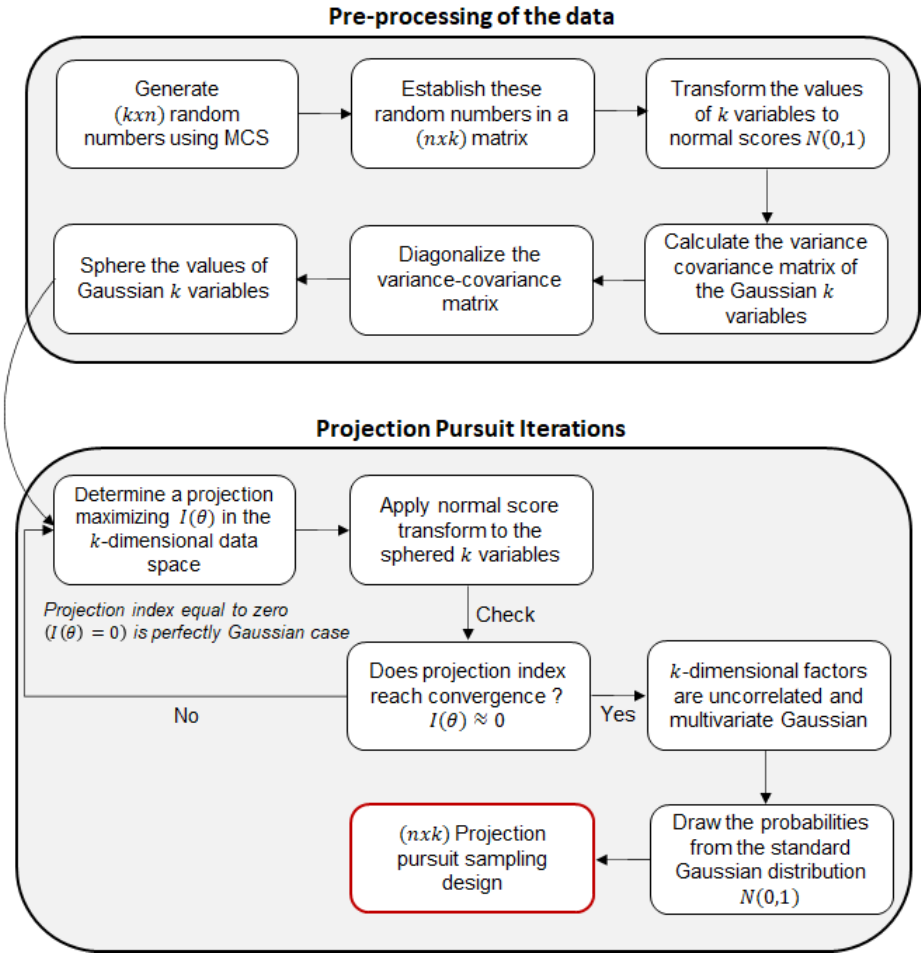
Figure 4. A flowchart indicating the steps for generating a sampling design using PPMT. Considering the two-dimensional sampling space ( k = 2 ) and ( n = 5 ) realizations, a sampling design generated by PPMT mapping the probabilities according to the given CDF are shown in Figure 5a,b, respectively.